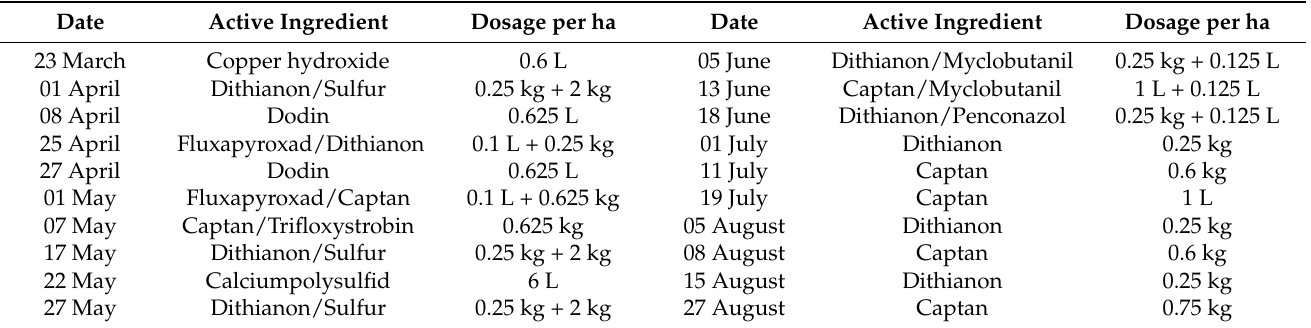
Table 1. Fungicide application with respective dosage per hectare (ha) prior to the experiment. Identical for all